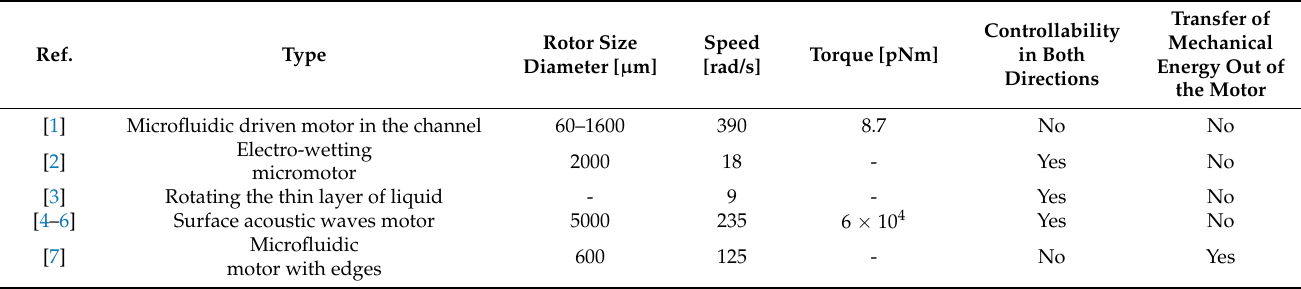
Table 1. Overview of microfluidic